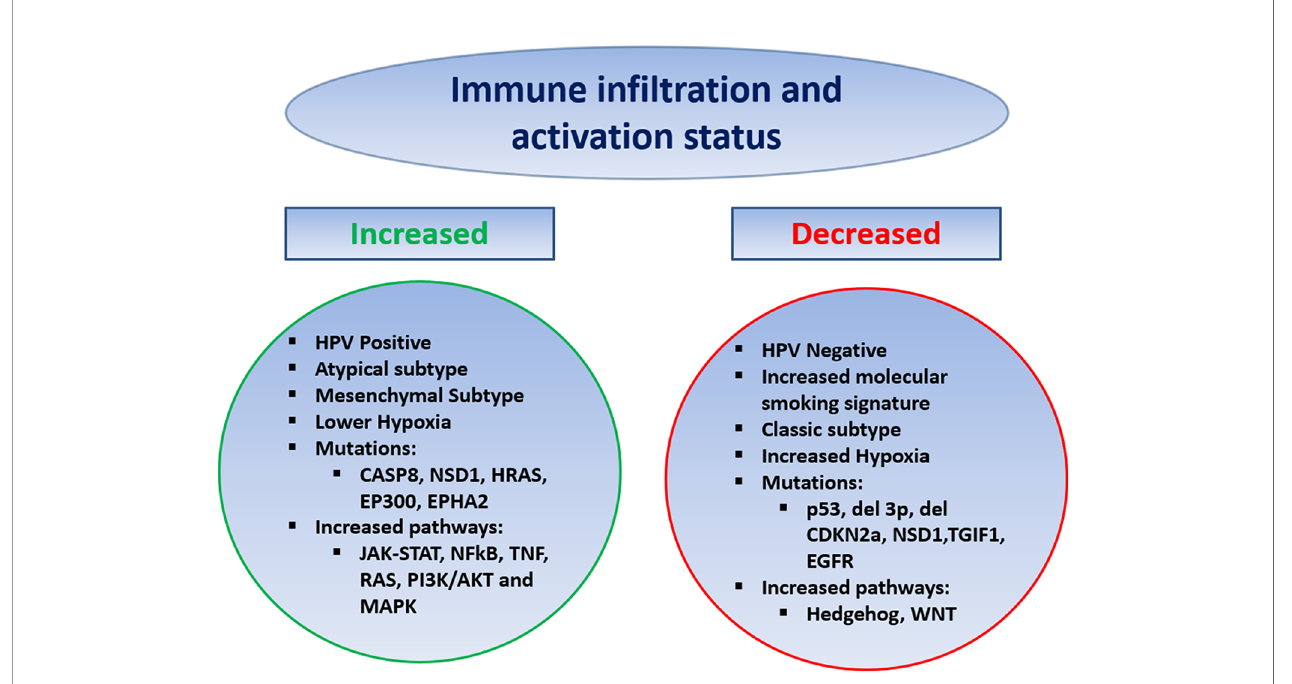
FIGURE 1 | Predictors of the Tumor Immune Microenvironment in